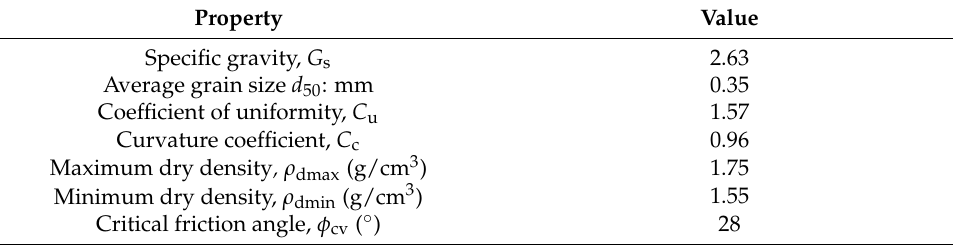
Table 1. Properties of silica sand.